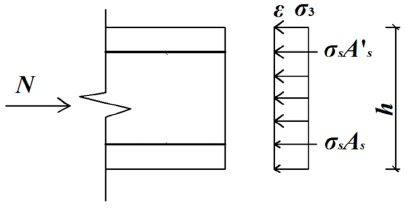
Figure 5. The stress and strain of the section corresponding to the axial